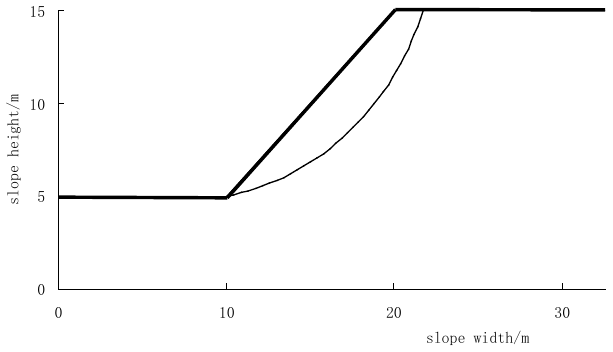
Figure 3. Cross section of the homogeneous slope in example 1.